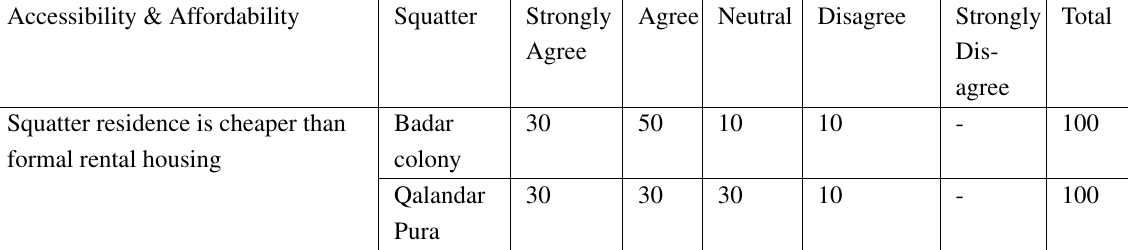
Table 2. Accessibility & Affordability issues of Squatters. Source: